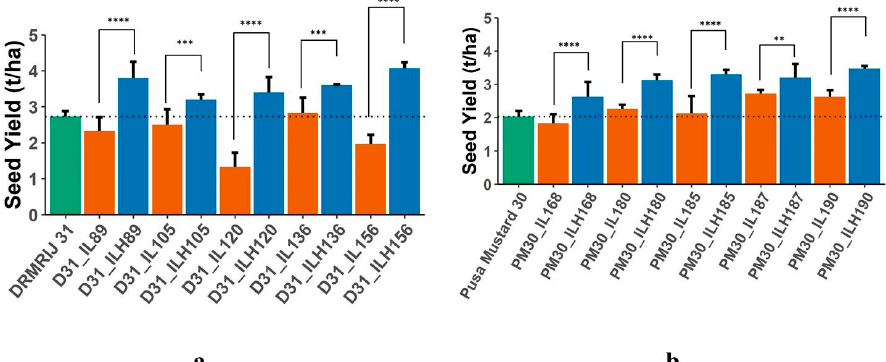
Figure 1. ( a ) Mean performance of DRMRIJ 31, introgression lines in its genetic background (D31_ILs) and introgression line hybrids (D31_ILHs) for seed yield; ( b ) Mean performance of Pusa Mustard 30, introgression lines in its genetic background (PM30_ILs) and introgression line hybrids (PM30_ILHs) for seed yield (** significant at p = 0.05; *** significant at p = 0.01; **** significant at p = 0.001; NS = Non Signi fi cant).